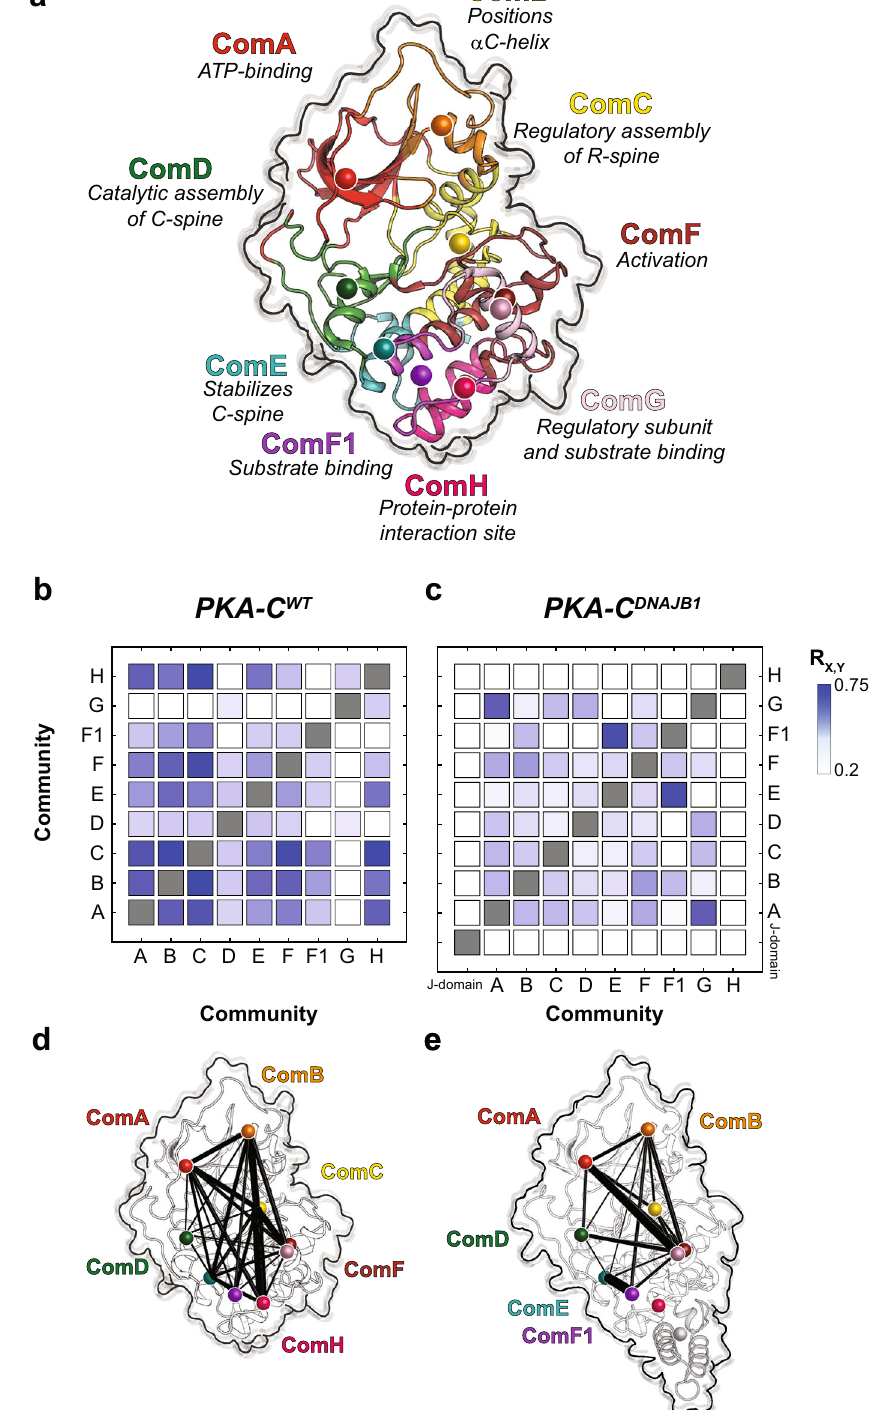
Fig. 4 Reduced cross-talk among structural communities of chimeric PKA-C DNAJB1 relative to PKA-C WT . a Structure of PKA-C highlighting all communities and their roles in various functions and regulatory mechanisms. CHESCA community matrices for b PKA-C WT and c PKA-C DNAJB1 upon binding PKI 5 – 24 . d – e CHESCA community matrices plotted on their corresponding structures. The size of each node is independent of the number of residues it encompasses, meanwhile the weight of each line indicates the strength of coupling between the individual